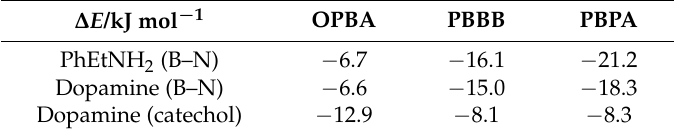
Table 3. Receptor–analyte complex formation energies ( ∆ E). In the case of dopamine, two different complexation modes (through B–N interaction and catechol ester formation) are